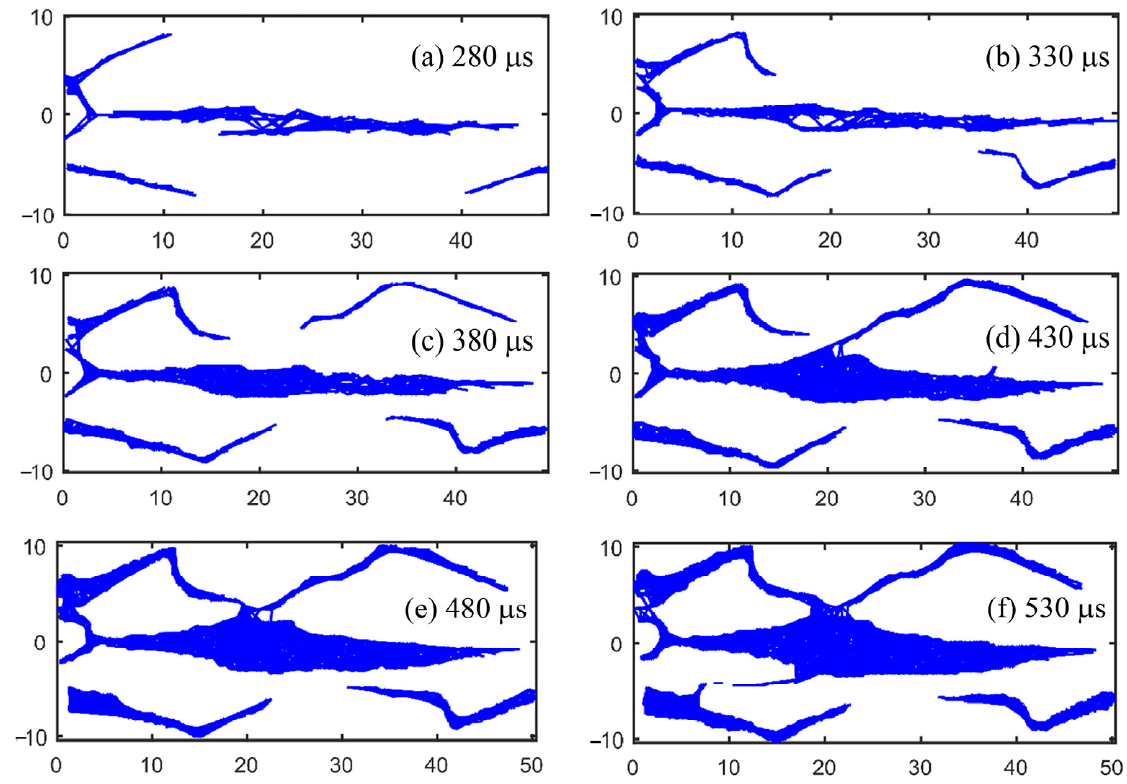
Figure 10. The fracture traces of the Andesite specimen at 4.88 m/s striking velocity obtained by FracPaQ: ( a ) 280 µ s; ( b ) 330 µ s; ( c ) 380 µ s; ( d ) 430 µ s; ( e ) 480 µ s; ( f ) 530 µ s.